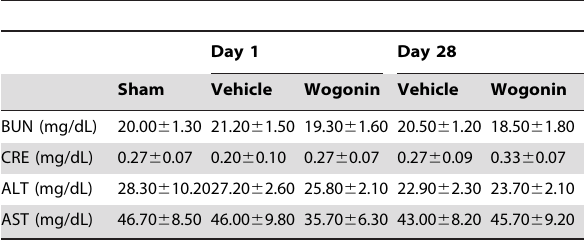
Table 1. Metabolic characteristics of the sham control, mice treated with DMSO and 40 mg ? kg 2 1